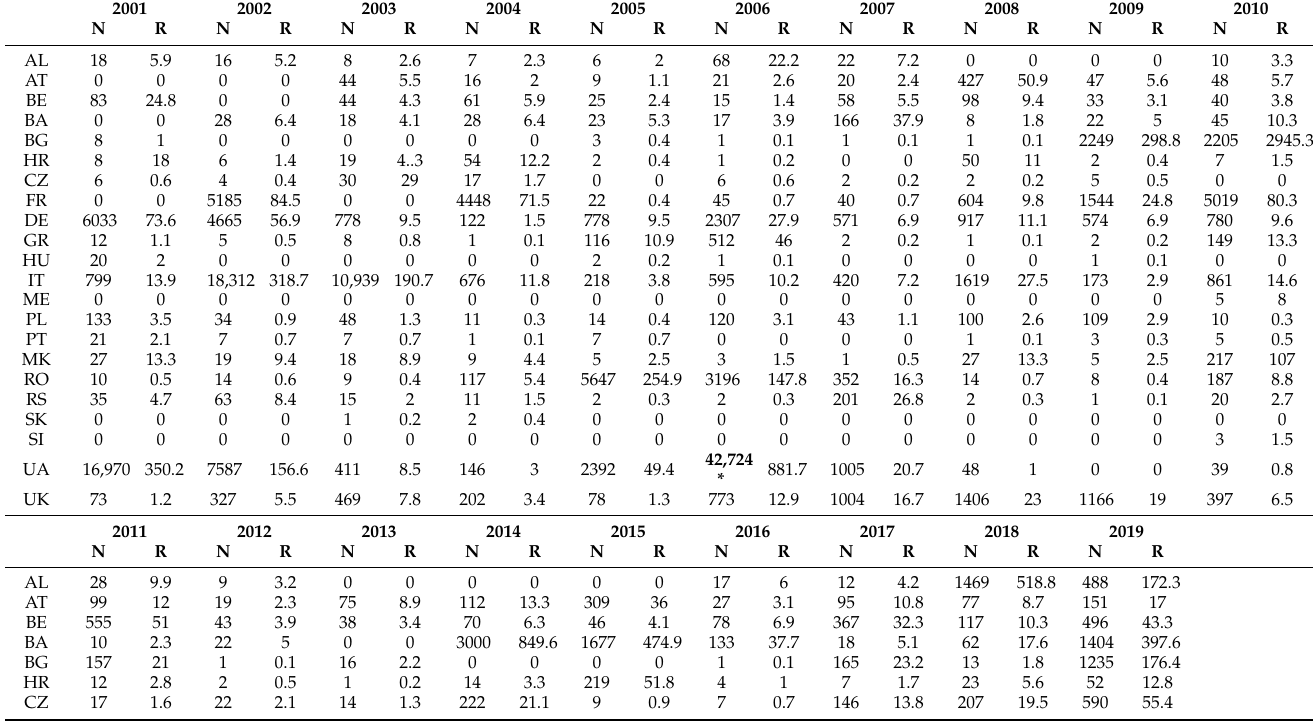
Table 7. Number and rate per 1,000,000 measles cases in selected European countries in